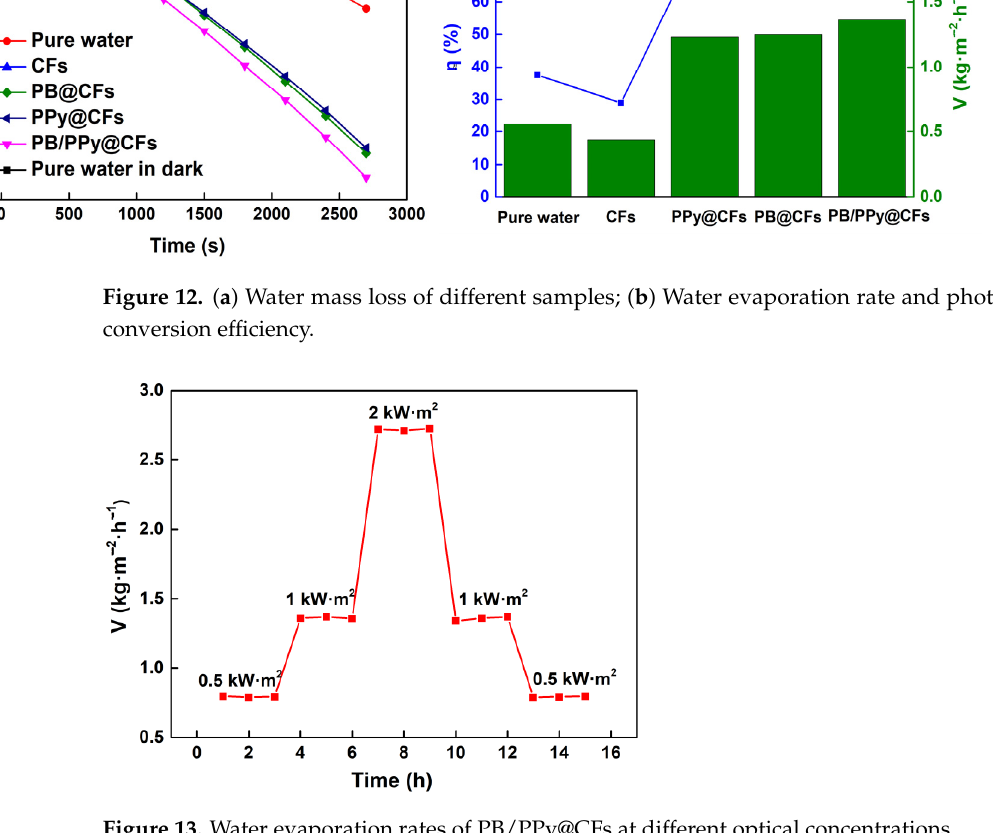
Figure 13. Water evaporation rates of PB/PPy@CFs at different optical concentrations.